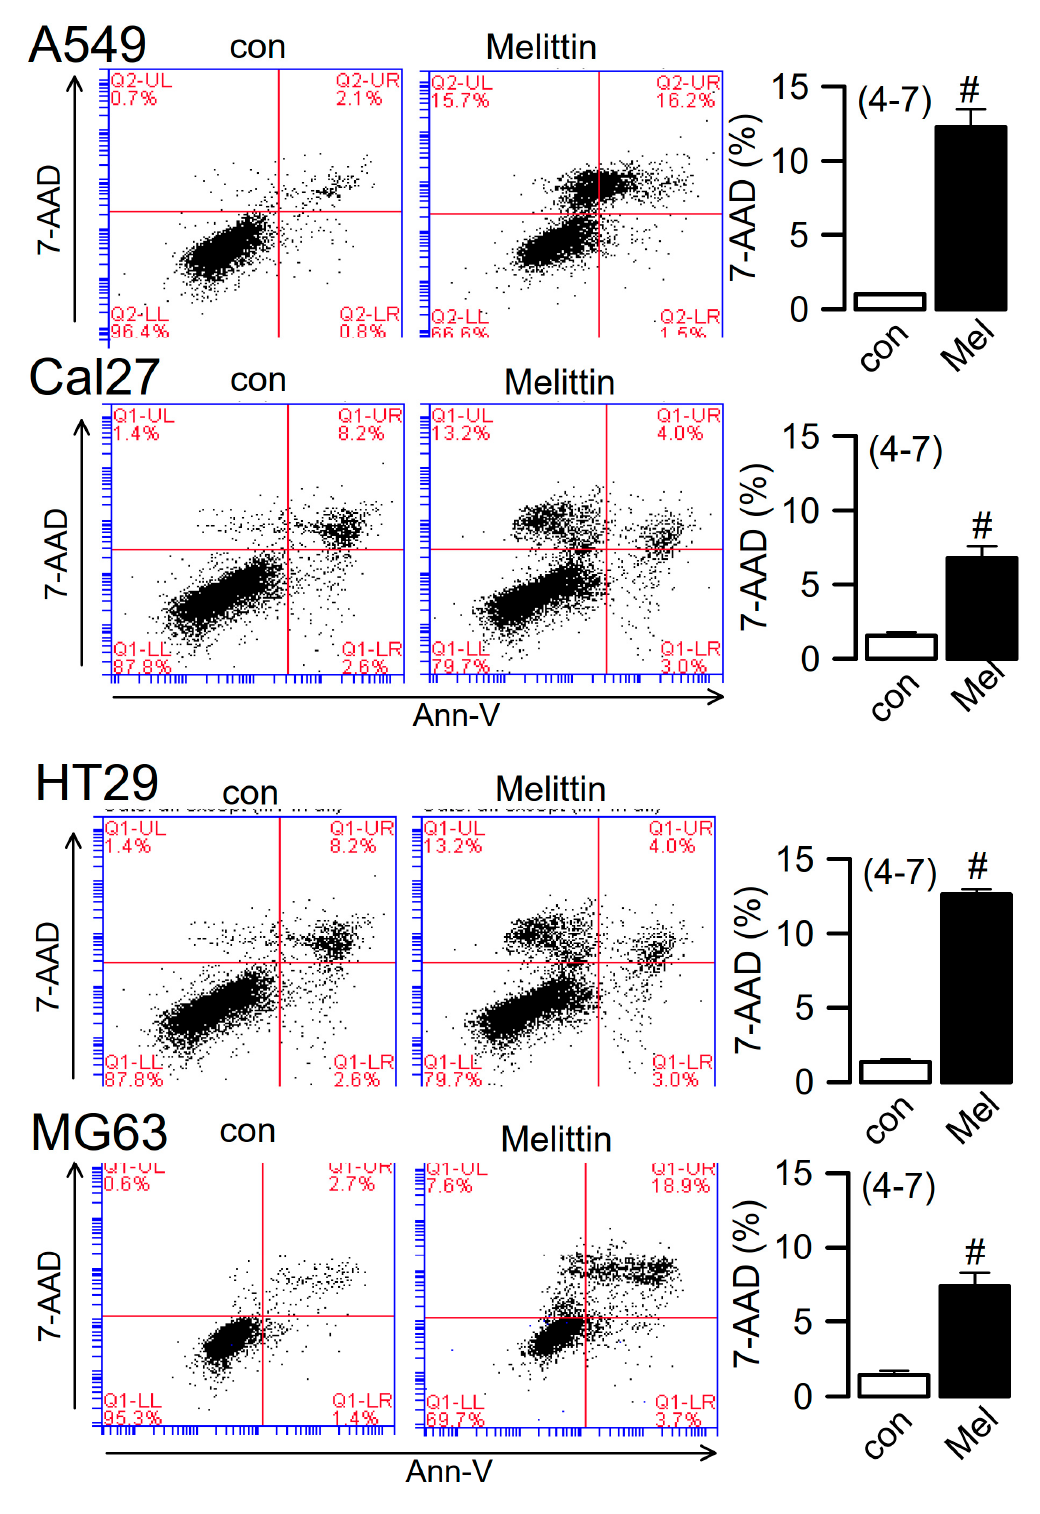
Figure 6. Melittin activated cell death of cancer cells. Dot blots indicating cell death (7-AAD positivity) induced by melittin (1 µM/14 h) in A549, Cal27, HT 29 and MG-63 cells. Summary of 7-AAD positivity before and after application of melittin. Mean ± SEM (number of experiments). # Significant difference when compared to control ( p < 0.05, unpaired t -test).